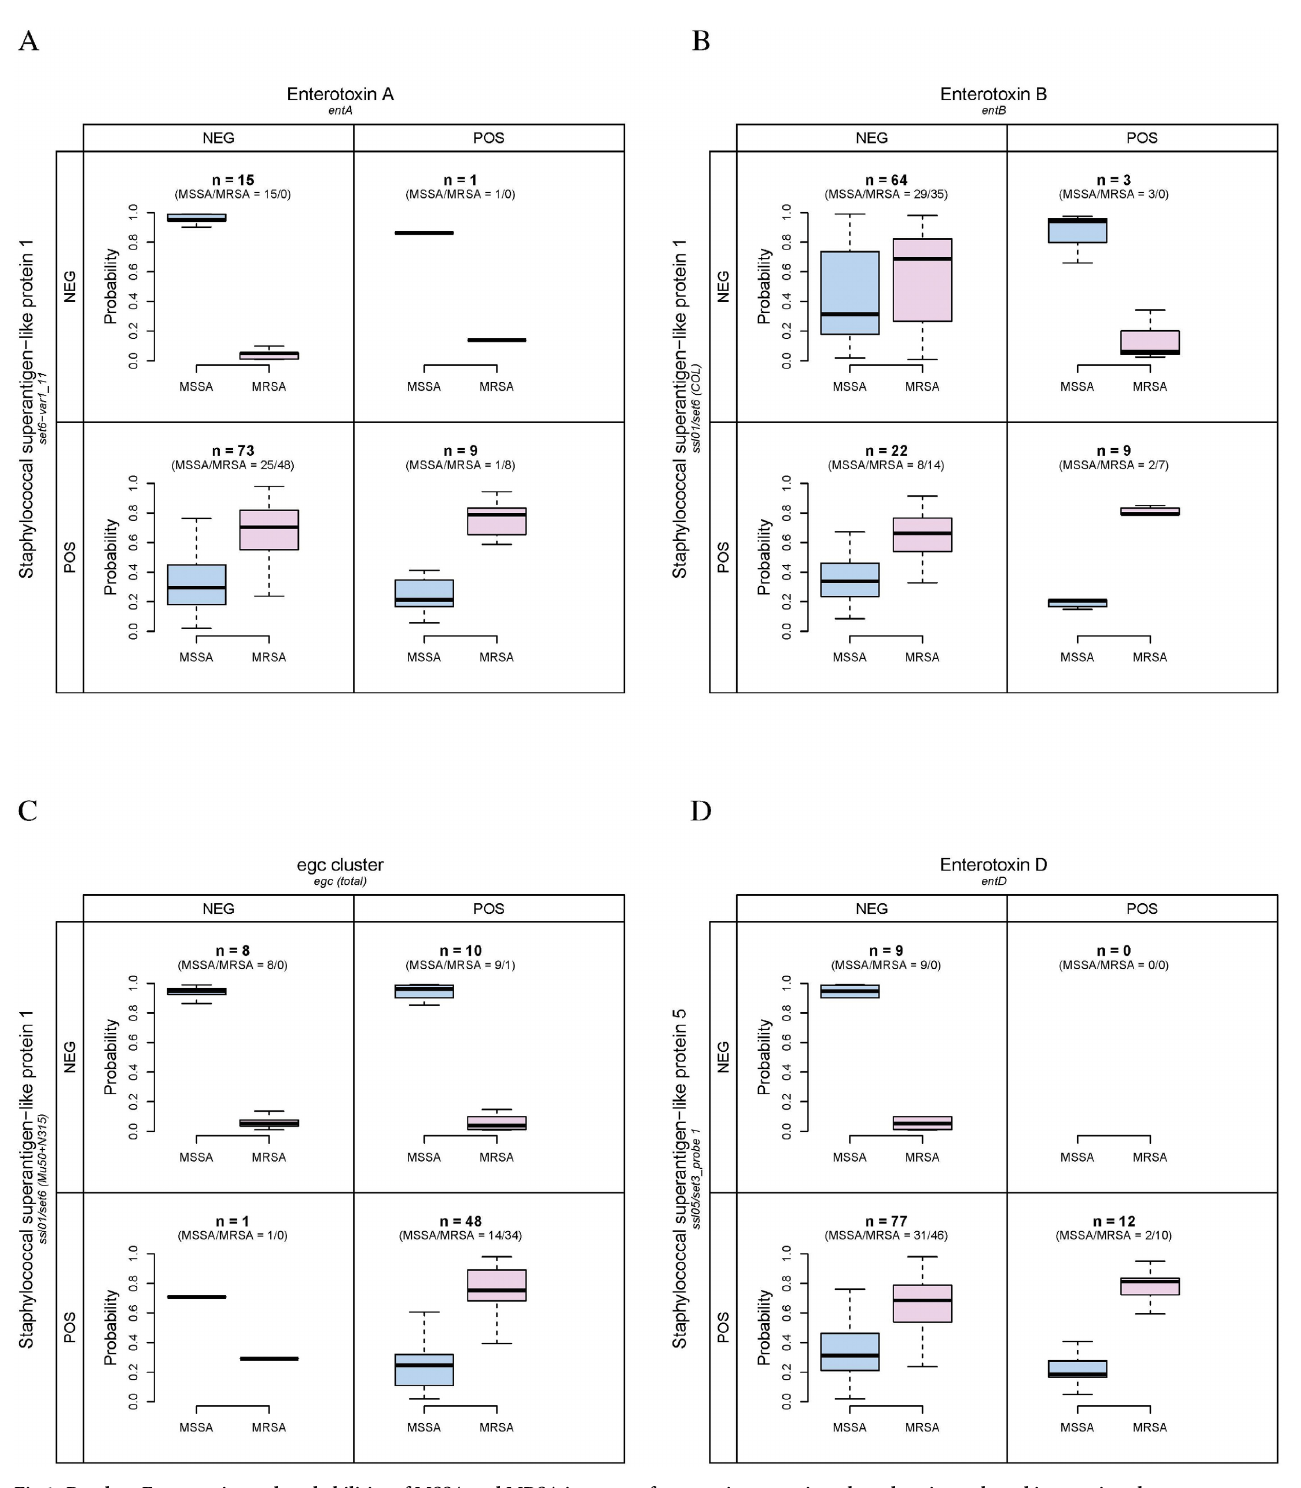
PLOS ONE | https://doi.org/10.1371/journal.pone.0254519 July 28, 2021 10 /